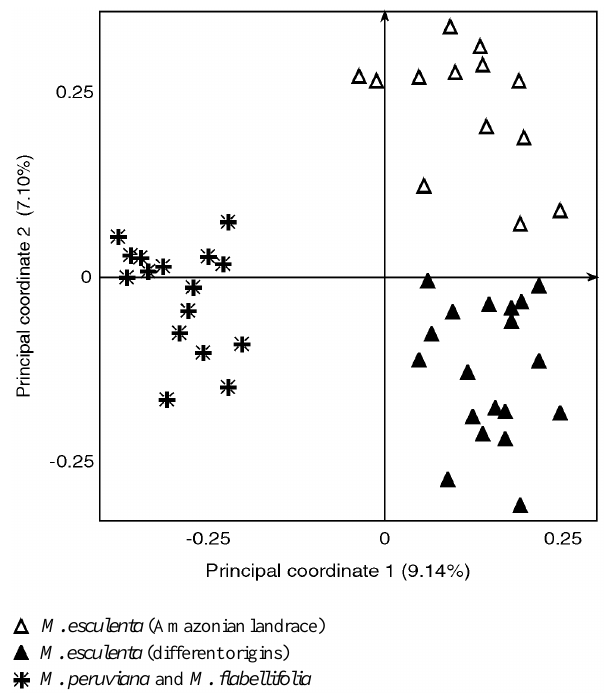
Figure 2 - Principal coordinate analysis calculated using the genetic similarities (Jaccard index) of 33 clonal accessions of cultivated cassava ( Manihot esculenta ) and 15 genotypes of the naturally occurring species M . flabellifolia and M. peruviana